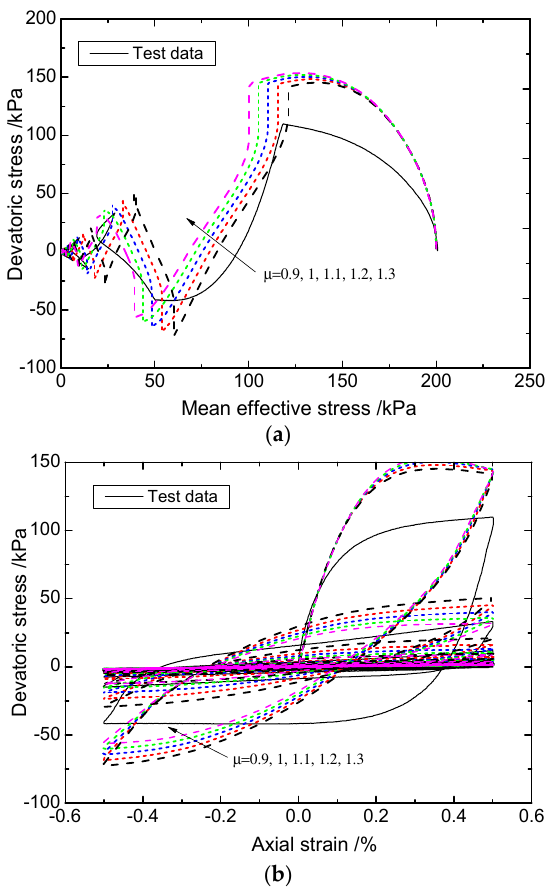
Figure 3. Model predictions of the strain-controlled undrained cyclic behavior of Karlsruhe fine sand under an axial strain amplitude of 0.5%: ( a ) stress path; ( b ) stress–strain relationship.